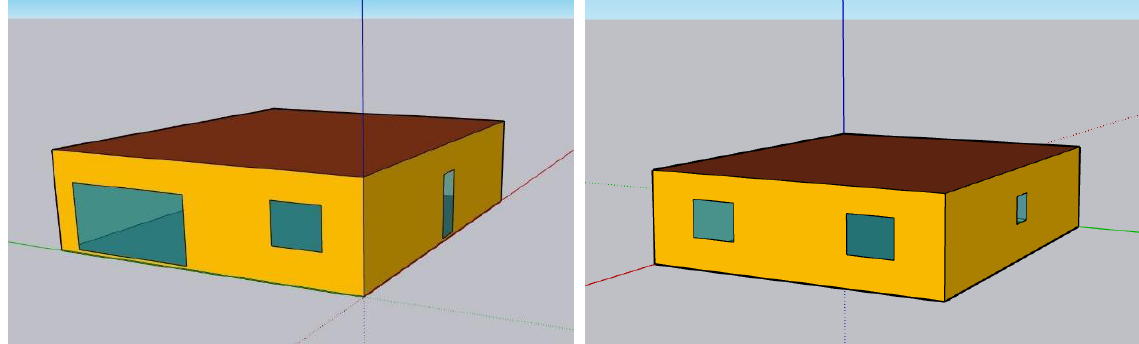
Figure 2. Model of the analyzed building created in